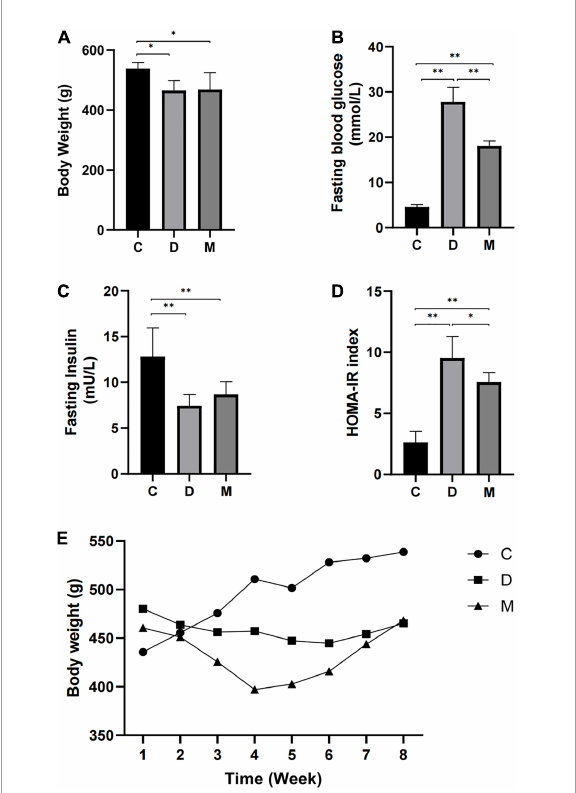
FIGURE1 Body weight, fasting blood glucose, fasting insulin, and HOMA-IR after 8 weeks of MOTS-c treatment. (A) Rats in groups D and M had lower body weights compared with rats in group C ( p < 0.01). (B) Rats in groups D and M had higher FBG compared with rats from group C ( p < 0.01). Values for FBG in M were significantly lower than that in group D ( p < 0.01). (C) Rats from groups D and M groups had lower FINS compared with rats from group C ( p < 0.01). (D) Rats from groups D and M had higher HOMA-IR values compared with group C ( p < 0.01). Values of HOMA-IR in group M were significantly lower than in group D ( p < 0.05). (E) The weekly body weight of rats in groups C, D and M. Data are expressed as mean ± SD; n = 10 rats per group; ∗ p < 0.05, ∗∗ p < 0.01; C, non-diabetic control group; D, diabetic control group; M, diabetic MOTS-c injection